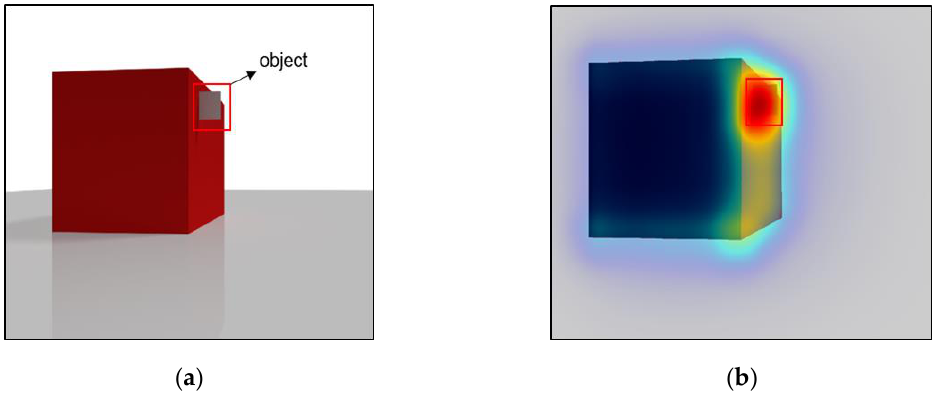
Figure 9. A frame in which ( a ) an object is extracted and ( b ) saliency of the object is determined.